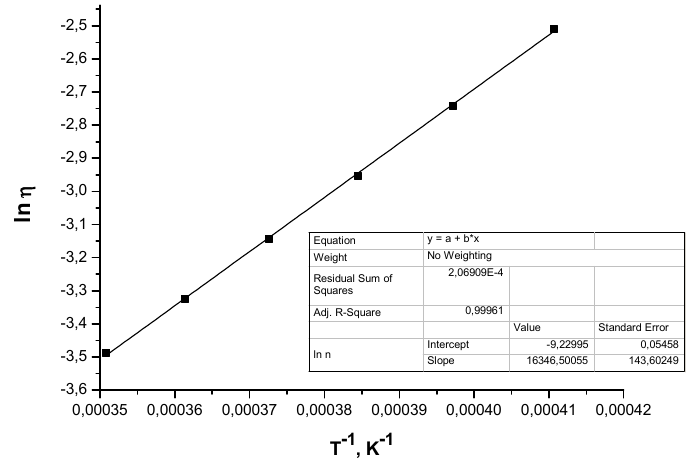
Figure 9. Defining E a for Ph 4 -15 polymer. They have linear shape that allows to calculate viscous flow activation energy ( Е а ) for all SSPs .